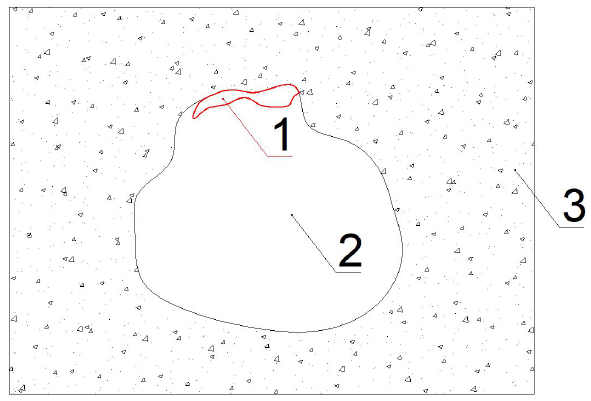
Figure 3: General image of a macropore: 1 – an open macropore filled with air, 2 – dry soil – supply area of the macropore, 3 – satu- rated soil.